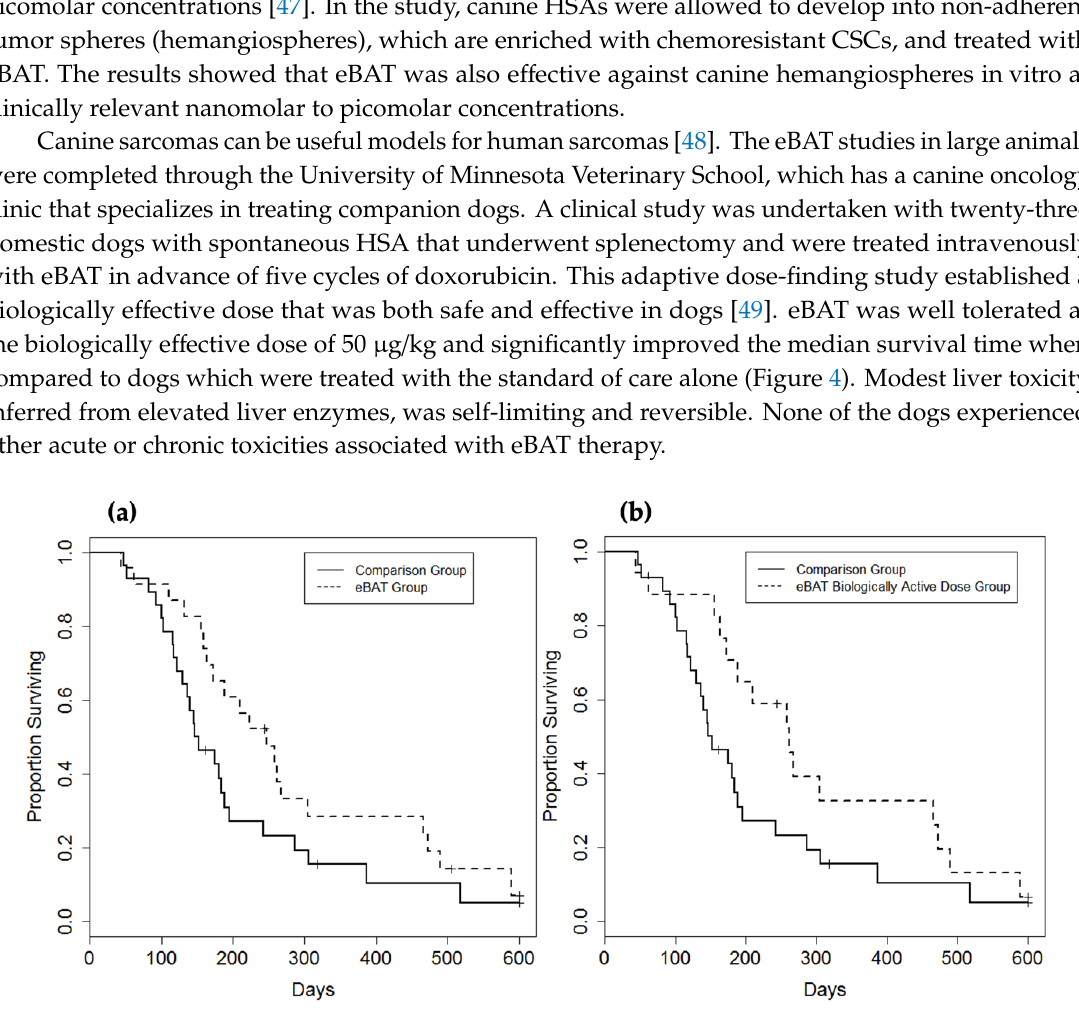
Figure 4. Effect of eBAT on survival of dogs with splenic hemangiosarcoma treated with adjuvant doxorubicin chemotherapy [35]. ( a ) Kaplan–Meier curve for all 23 dogs in the SRCBST-1 study versus the comparison dogs which received standard of care treatment. ( b ) Kaplan–Meier curve for the 17 dogs treated at the biologically effective dose versus the comparison dogs. Curves illustrate prolongation of survival in dogs treated with eBAT compared with the comparison group. Reprinted with permission of American Association for Cancer Research Journals.